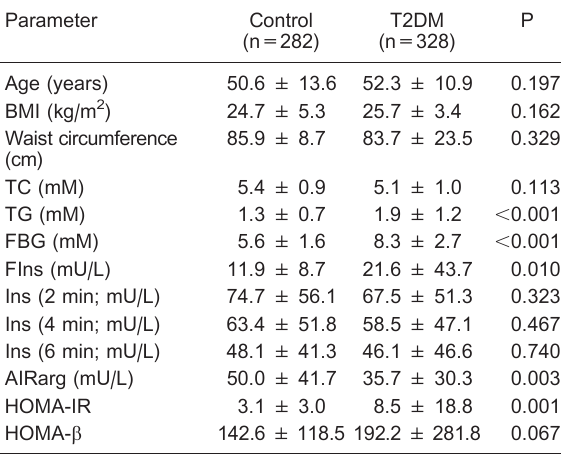
Table 2. Demographic and clinical characteristics of the study population. Parameter